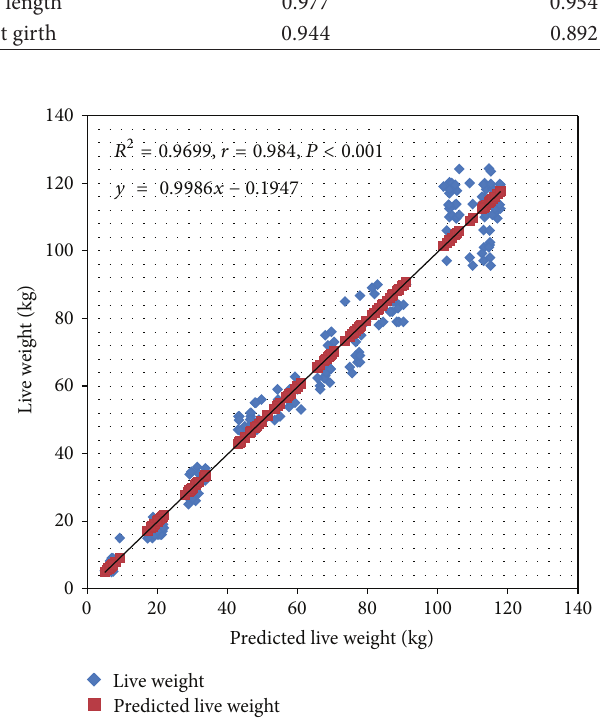
Figure 1: Cross-validation of model 1 ( 𝑛 = 202 ) with the second group of pigs ( 𝑛 = 156 ).